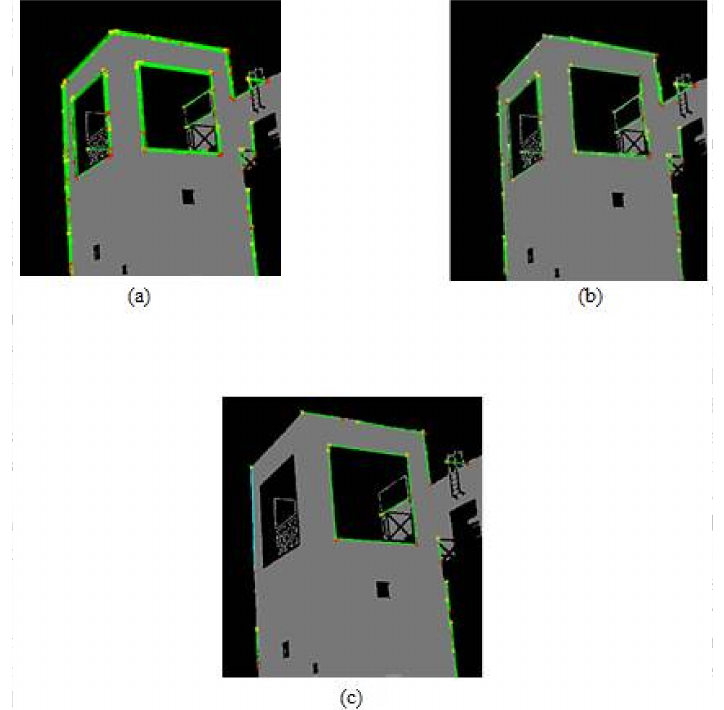
Figure 4. Building skeleton extraction process, campus building: ( a ) single application of edge detection—Hough line segment procedure; ( b ) sequential application of the edge detection—Hough line segment procedure, using a different set of parameter values, as in [31]; and ( c ) refined 2D skeleton of the building by applying the line strength evaluation function and the collinear and line parallelism